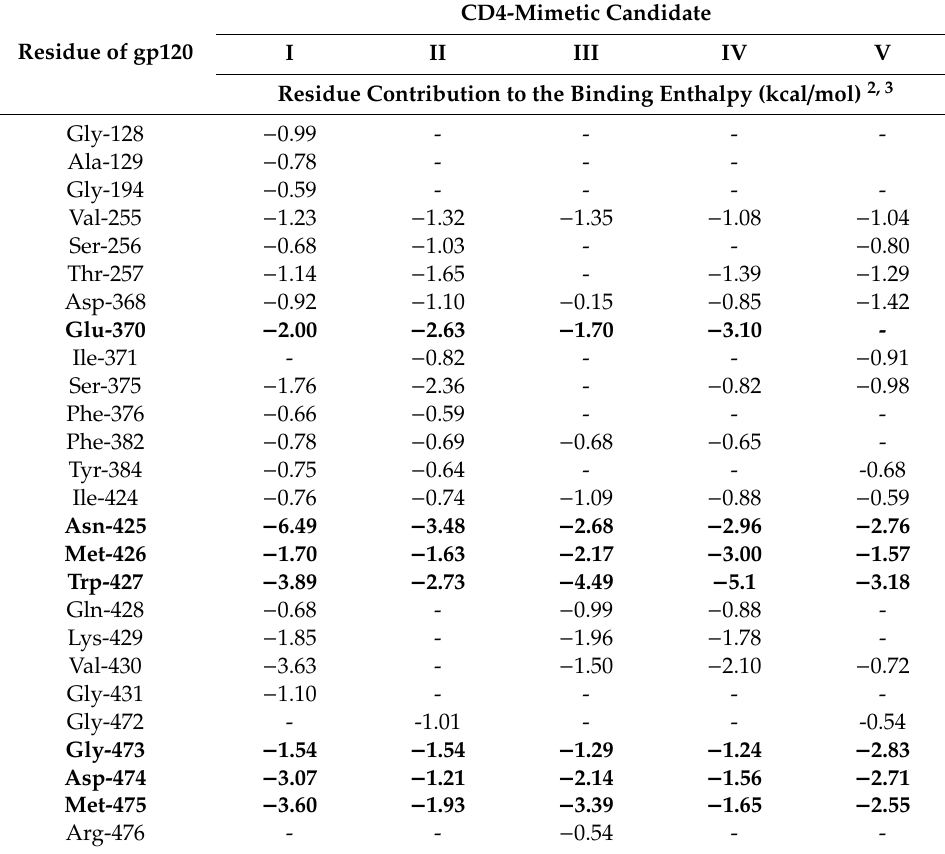
Table 5. Averages of the binding enthalpy for the amino-acid residues of gp120 bound to the CD4-mimetic candidates 1